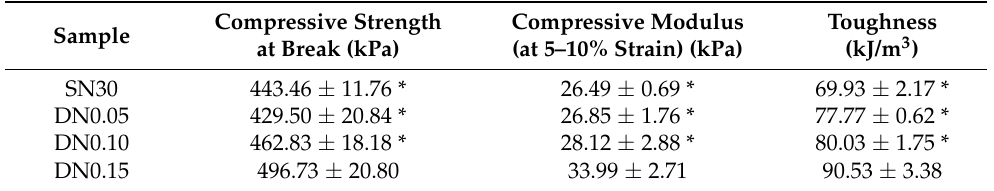
Table 4. Compressive properties of SN starch hydrogel (30 mL of GA and 24 h of crosslinking time) and DN starch hydrogels ( n = 5, * p < 0.05 compared with DN0.15 hydrogel).